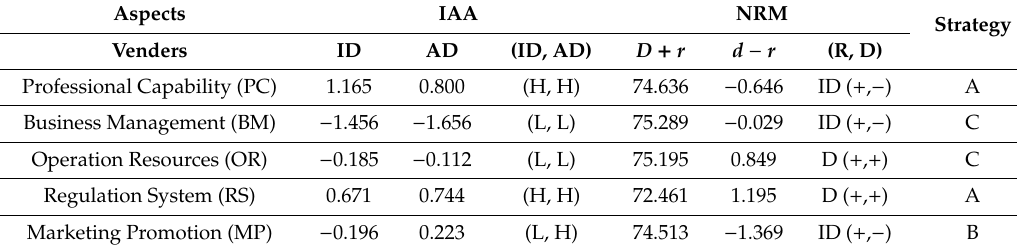
Figure 4. The Importance Accessibility Analysis-Network Relation Map (IAA-NRM) for vendors. Table 13. The development strategy for vendors.